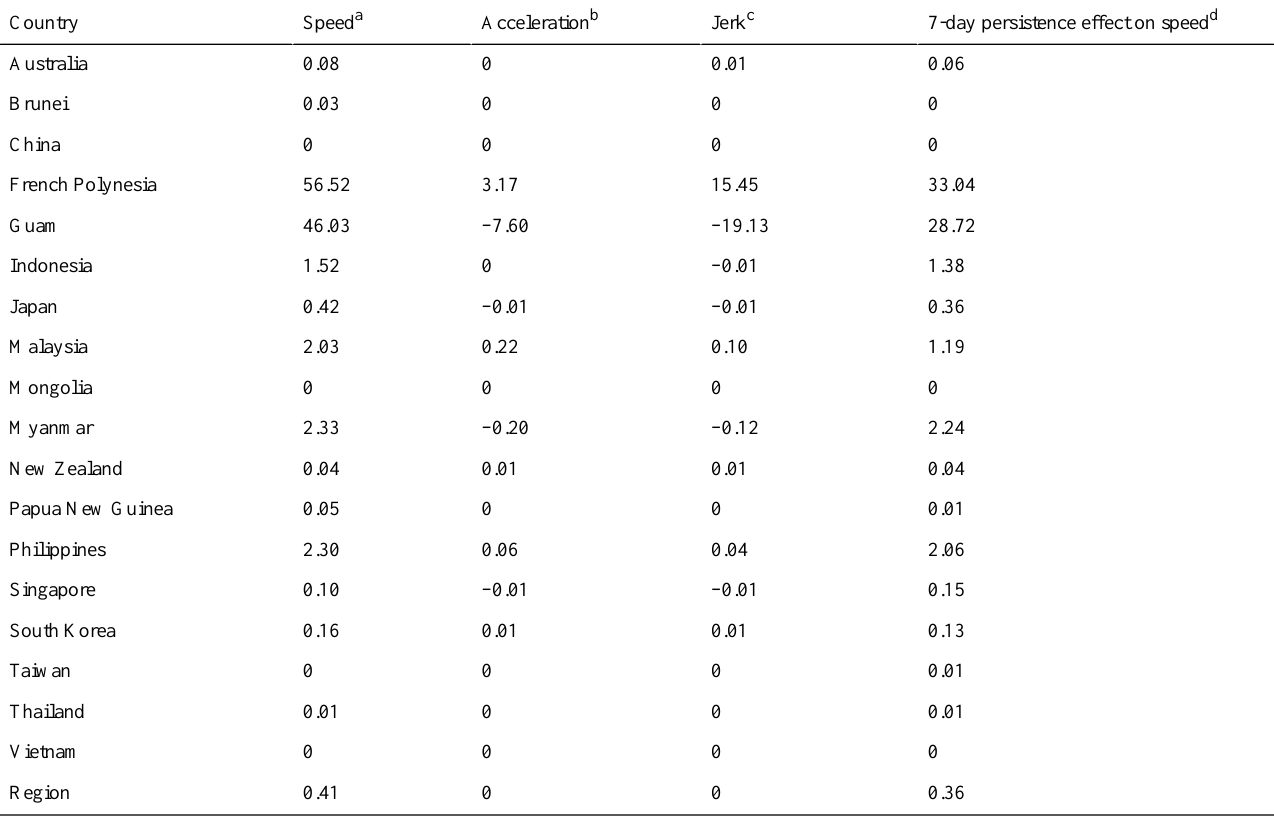
Table 5. Novel surveillance metrics for the week of October 12-18, 2020.